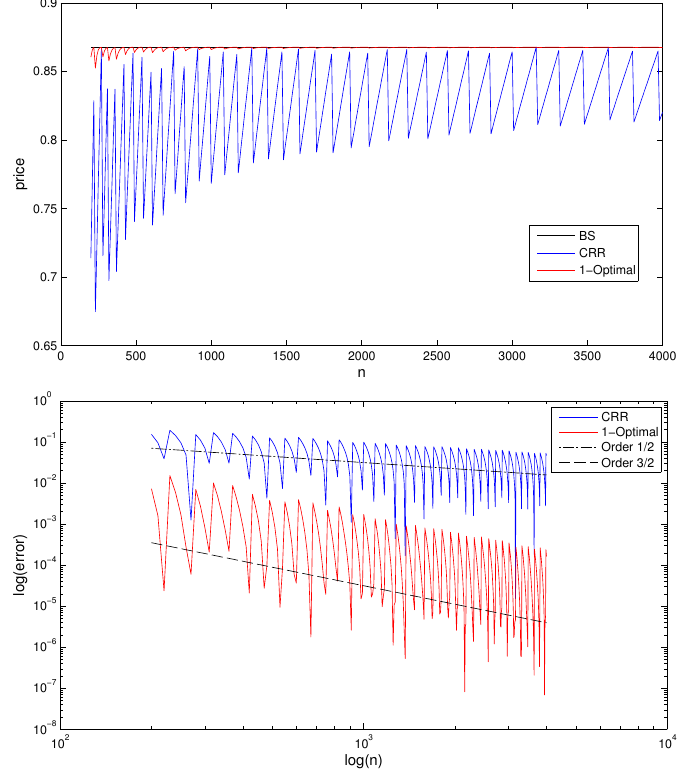
Figure 6. CRR vs. 1-opt.: Up-and-in barrier put, T = 1, r = 0.1, σ = 0.25, s 0 = 100, K = 105, B =